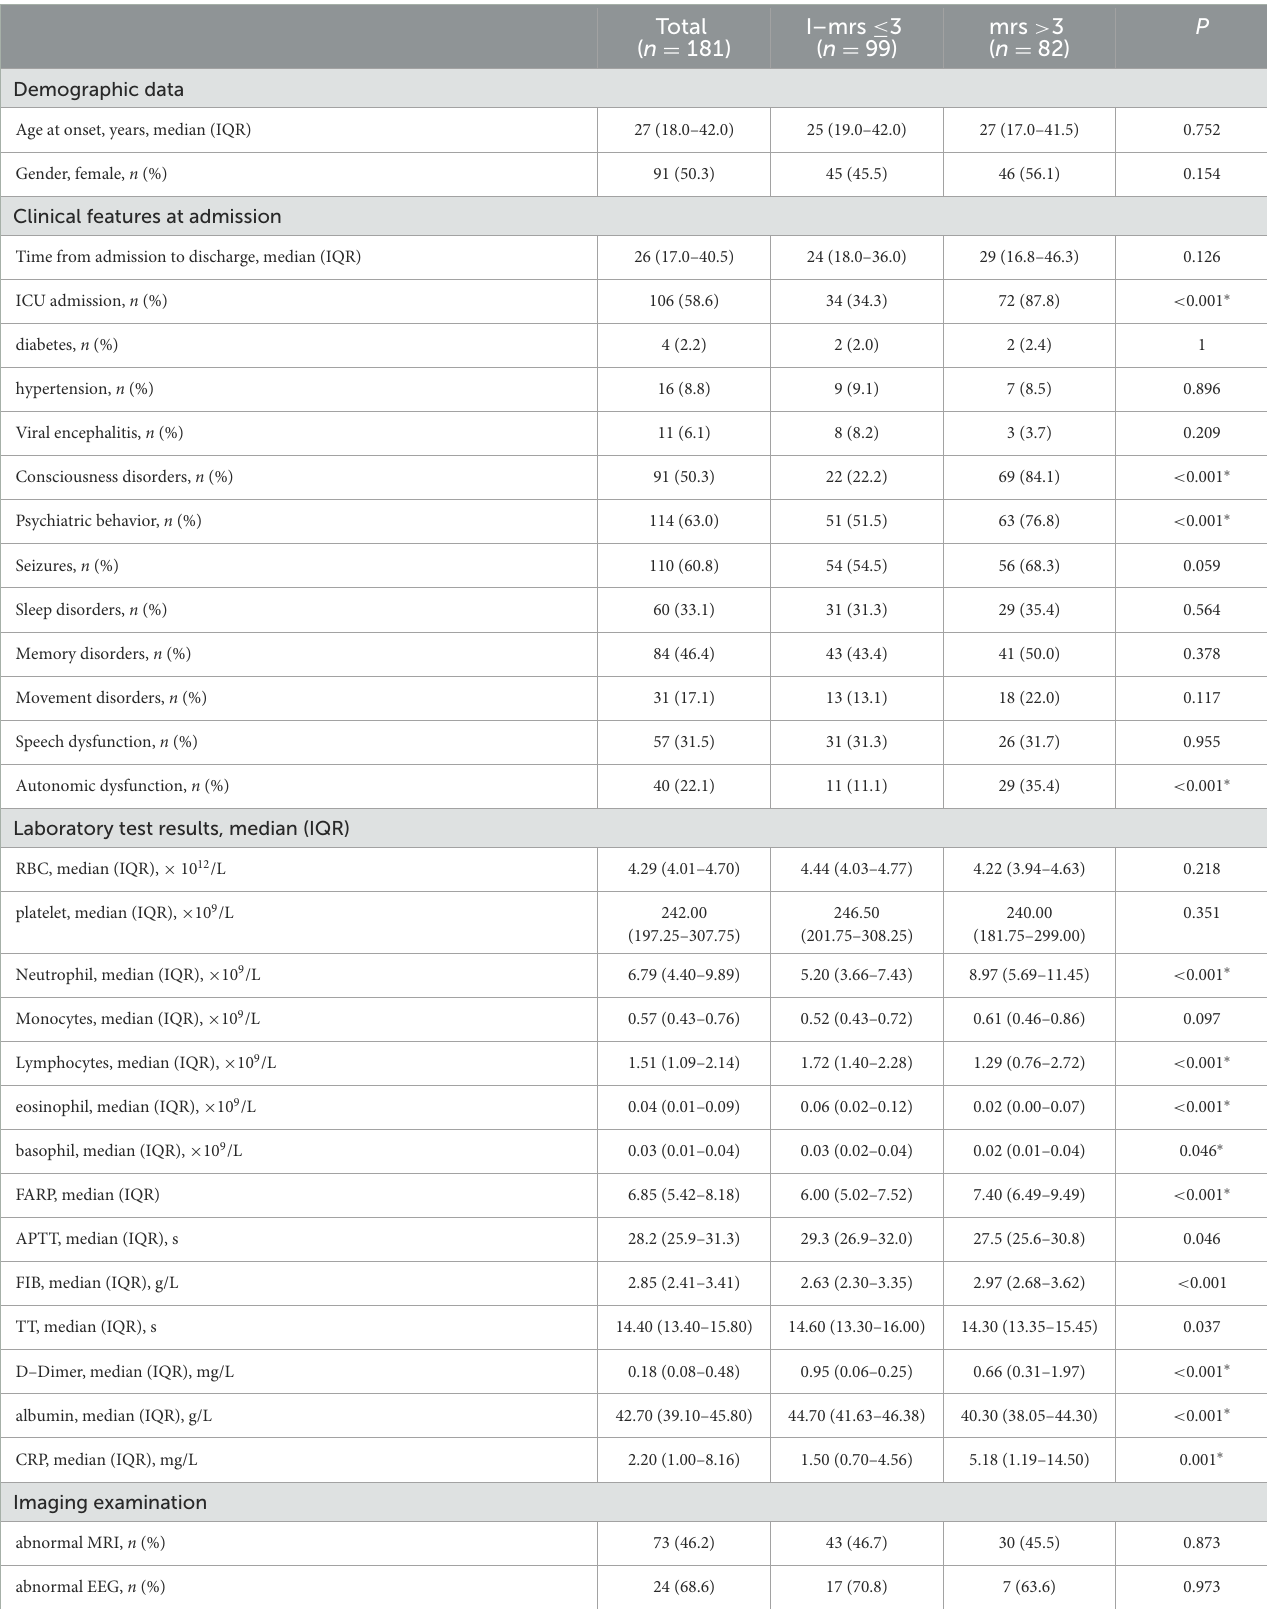
TABLE 2 Comparison of clinical data of anti-NMDAR encephalitis with different severity at